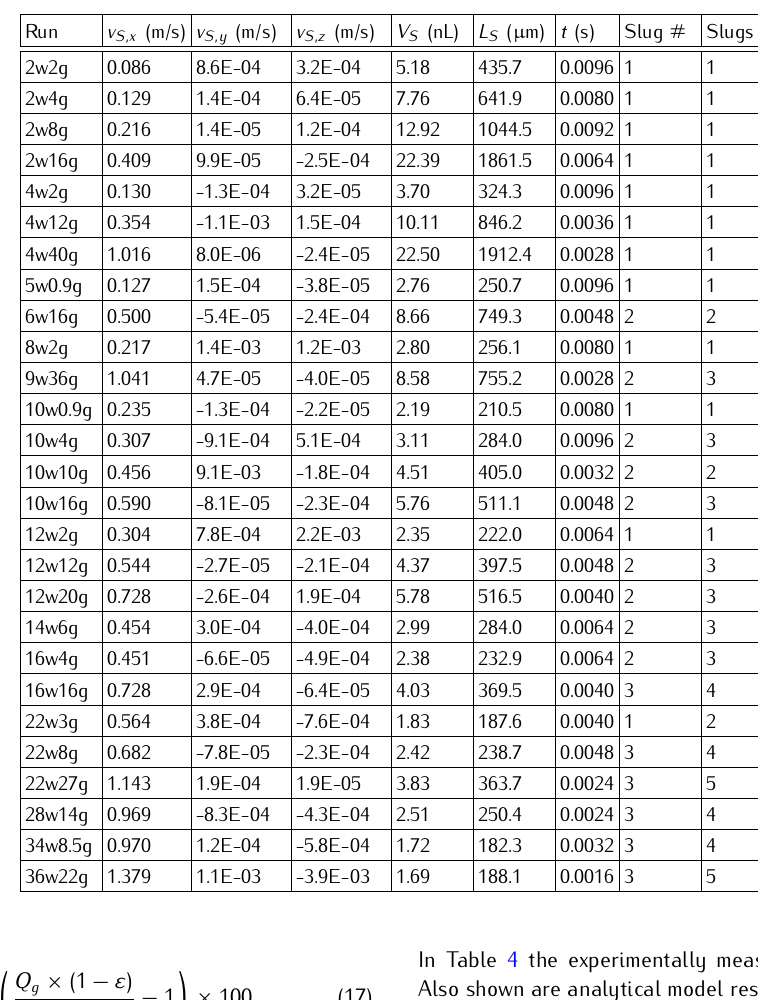
Table 2. Numerical simulation measured data